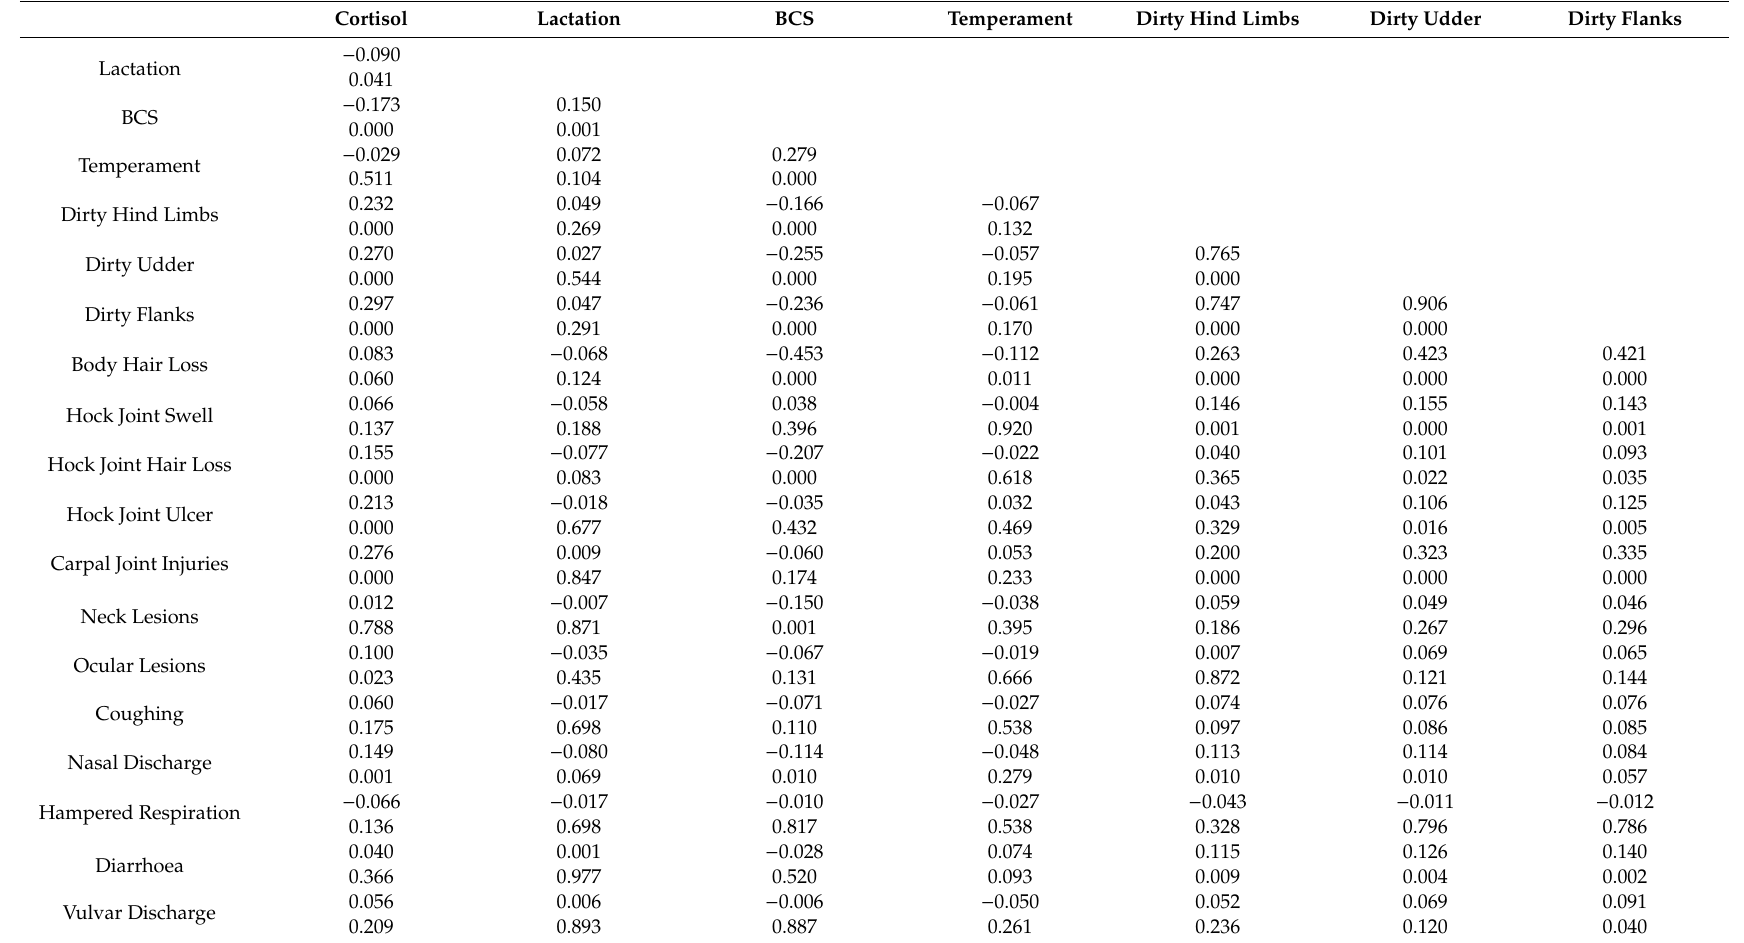
Table A2. Univariate correlations between variables in the animal-based measures. Cortisol Lactation BCS Temperament Dirty Hind Limbs Dirty Udder Dirty